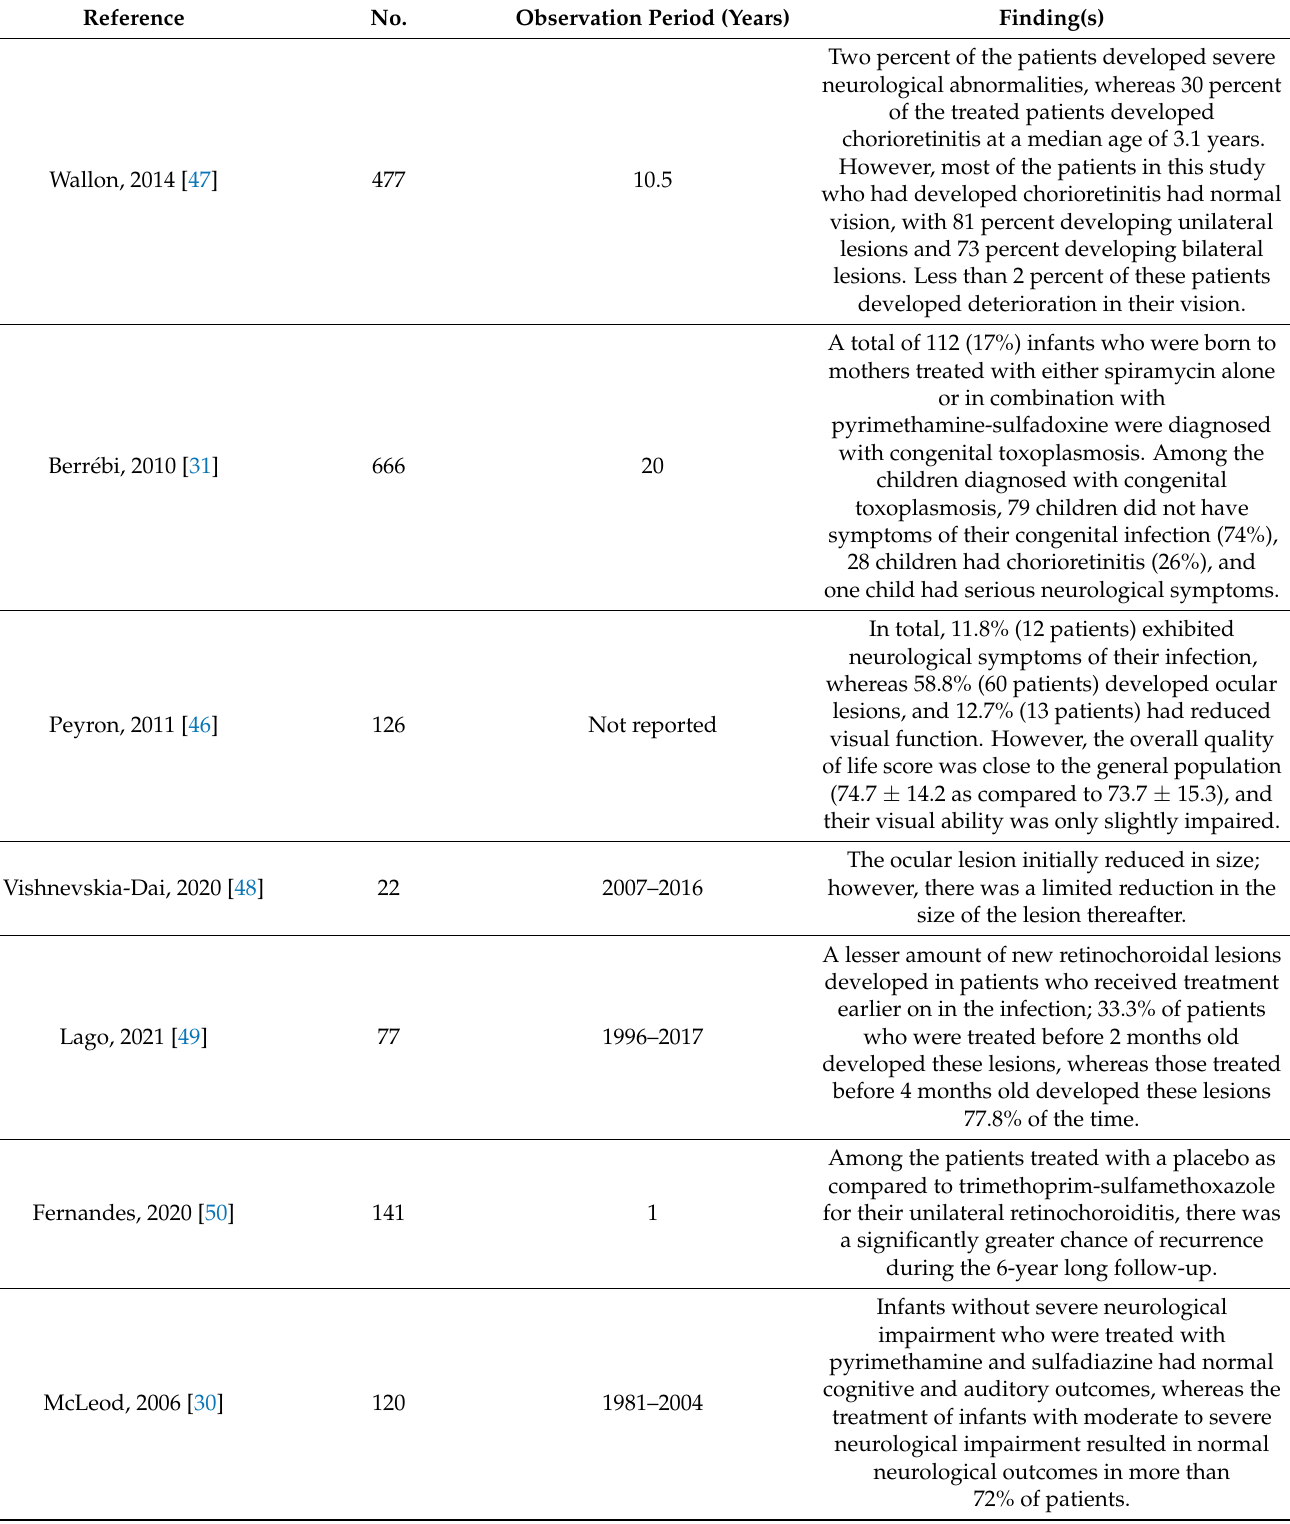
Table 1. Summary of studies treating